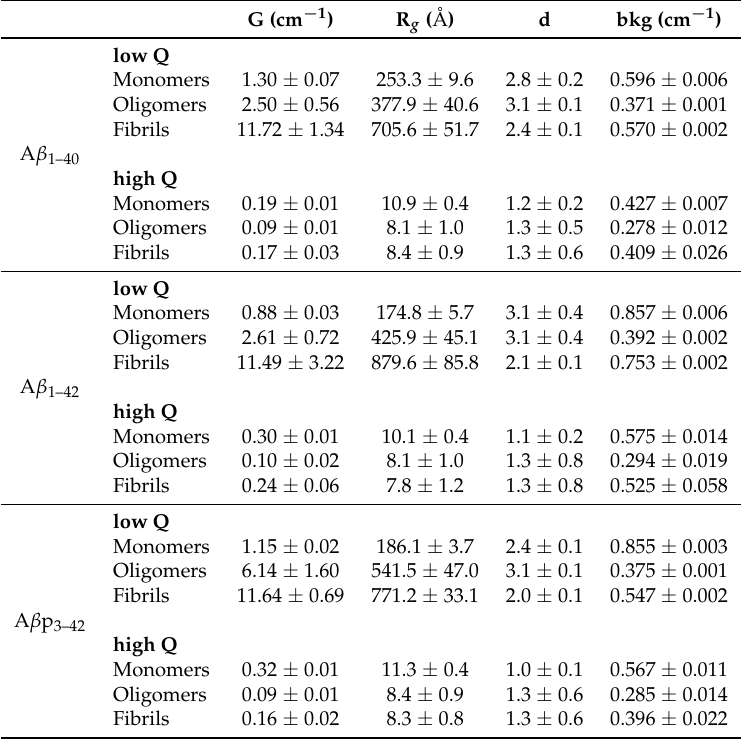
Figure 2. Best fit for small angle neutron scattering (SANS) spectra for monomers (top), oligomers (middle) and fibrils (bottom) of the A β 1–40 , A β 1–42 and A β p 3–42 peptides. The data are fitted with the Beaucage model in two wave-vector regimes: At low Q values (Q < 0.045 Å − 1 ) and at high Q values (0.045 Å − 1 < Q < 0.5 Å − 1 ), highlighted with different colors. The color horizontal lines represent the background value obtained from high Q data fit for each system. Some data have been scaled by a factor reported in the figure legend to avoid plots overlapping. Note that the experimental error bars are smaller than symbol size (except for a few points). Table 1. Fit parameters obtained by using the Becauge model at low Q (Q < 0.045 Å − 1 ) and at high Q (0.045 < Q < 0.5 Å − 1